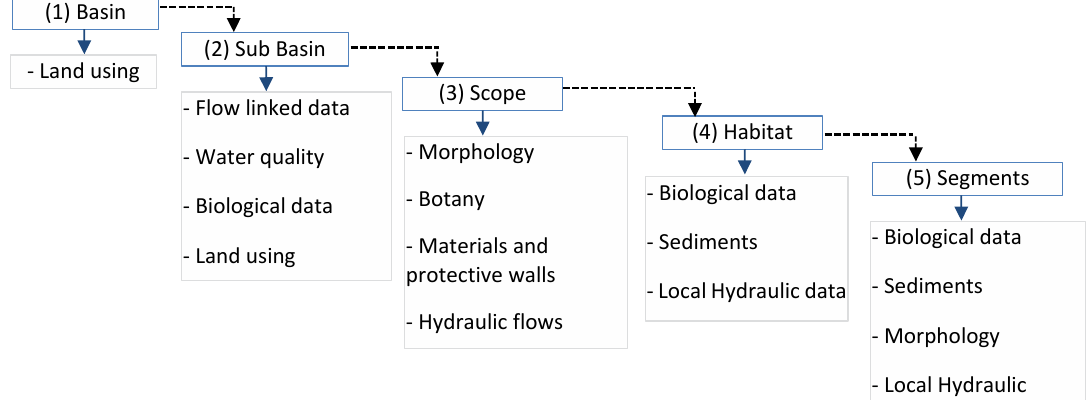
Fig. 2: Spatial hierarchical structure of basin integrated management (Linke et al ., 2019)